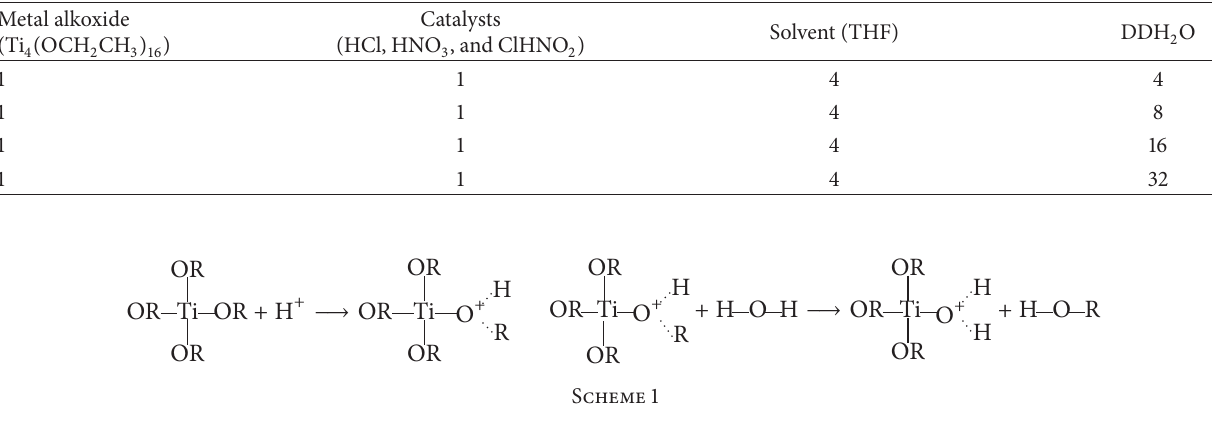
Table 1: Hydrolysis molar